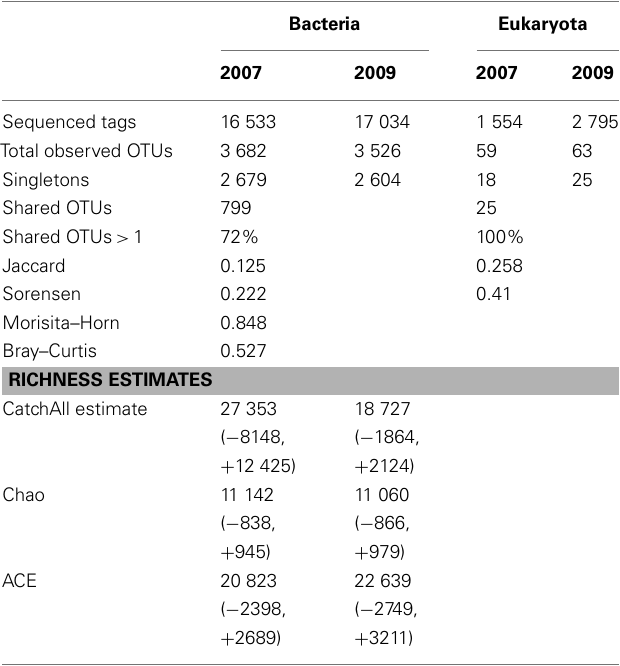
Table 2 | Sequencing summary, OTU distributions, and diversity